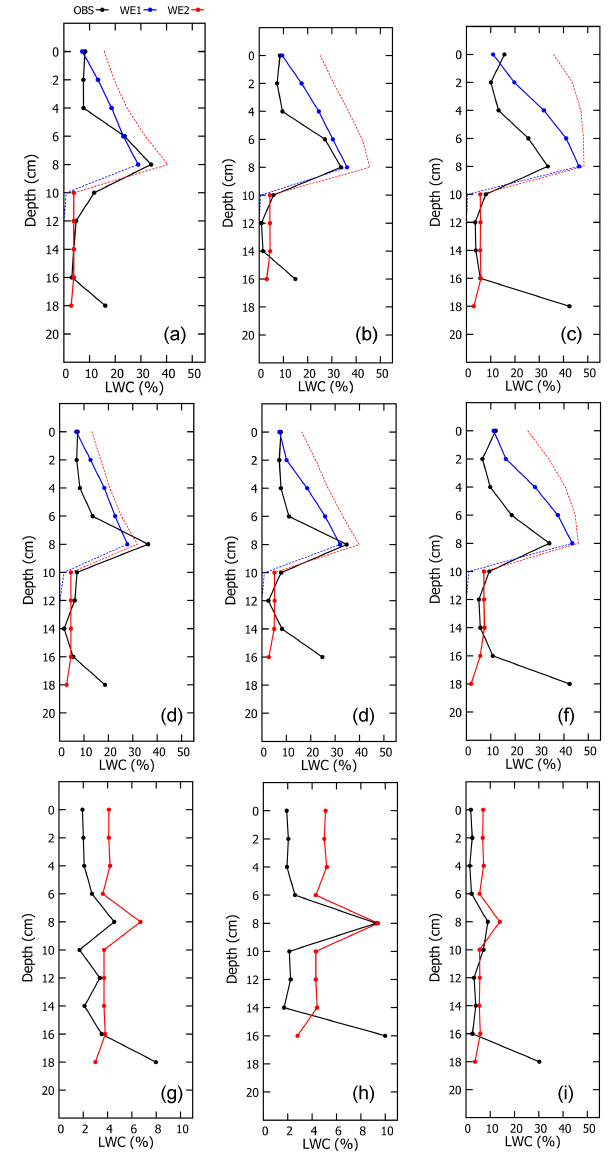
Figure 5. Comparison between observed and simulated profiles of volumetric LWC. (a) , (b) , and (c) refer to samples FC1, FC2, and FC3. (d) , (e) , and (f) refer to samples FM1, FM2, and FM3. (g) , (h) , and (i) refer to samples MC1, MC2, and MC3. Note that panels (g) and (h) have a different horizontal range from the others. Each point represents bulk LWC in the underlying 2cm. As described in Sect. 2.3, two simulated profiles are reported for FC and FM samples (WE1 and WE2), whereas only WE2 is reported for MC samples. Dashed lines indicate the parts of the profiles that are not considered in the discussion (see again Sect.